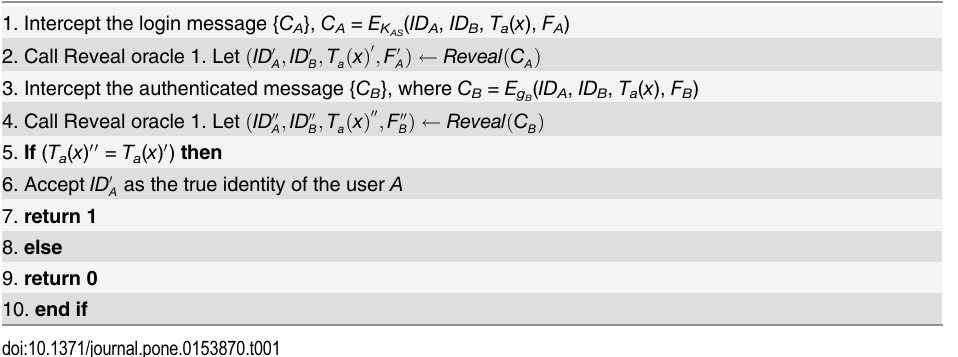
Table 1. Algorithm 1.